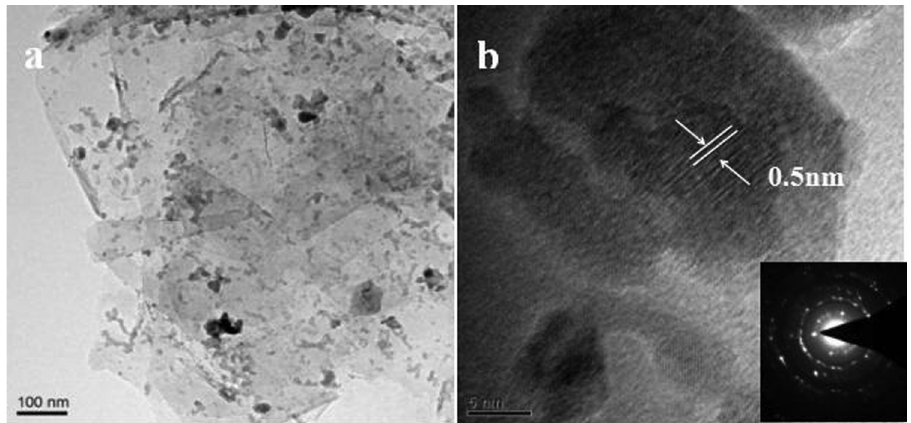
Figure 3: High - resolution transmission electron microscopy images of C@Al – EG